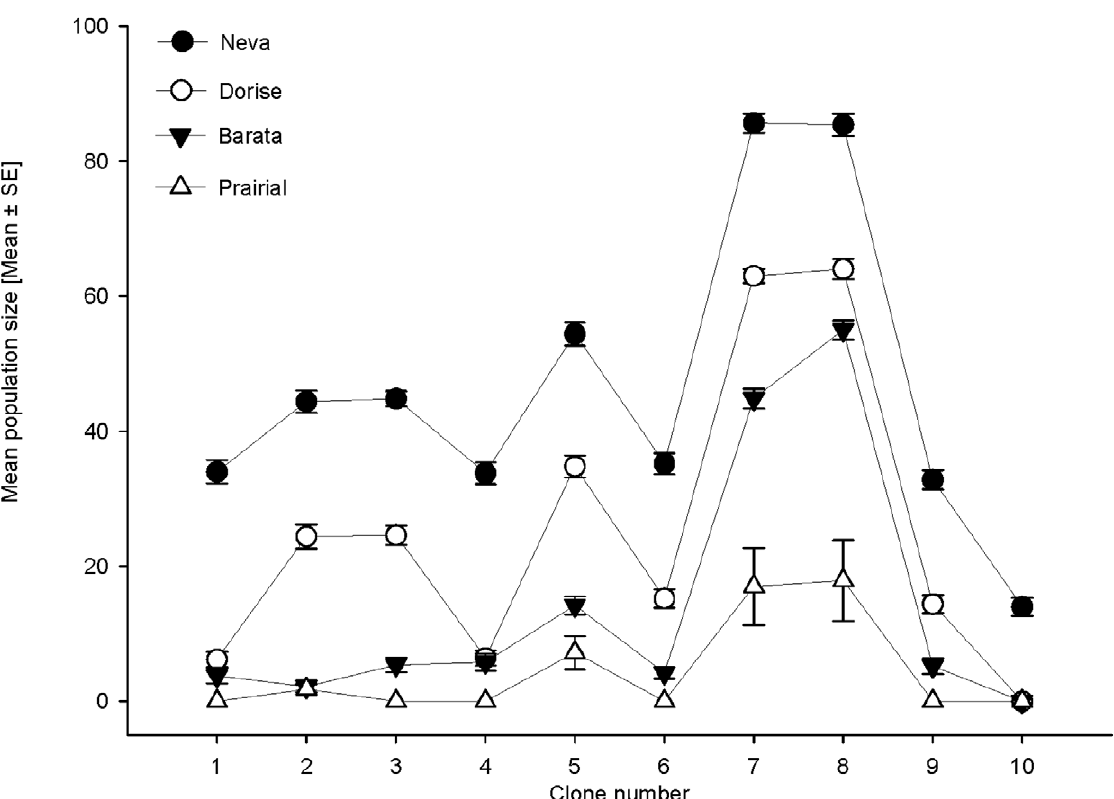
Figure 3. Mean population size of 10 clones S.avenae on 4 cocksfoot cultivars. Labels on the X axis refer to the number of the aphid clone tested.